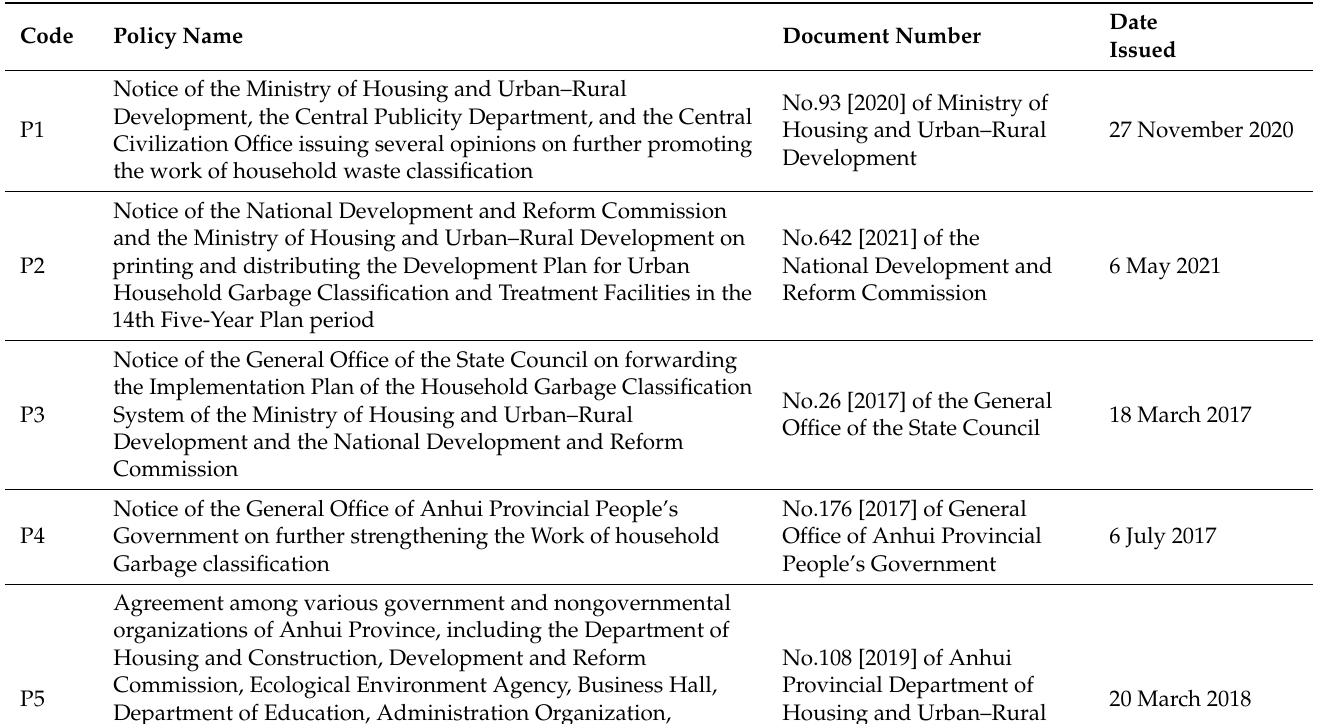
Table 4. The selected WSMPs in this